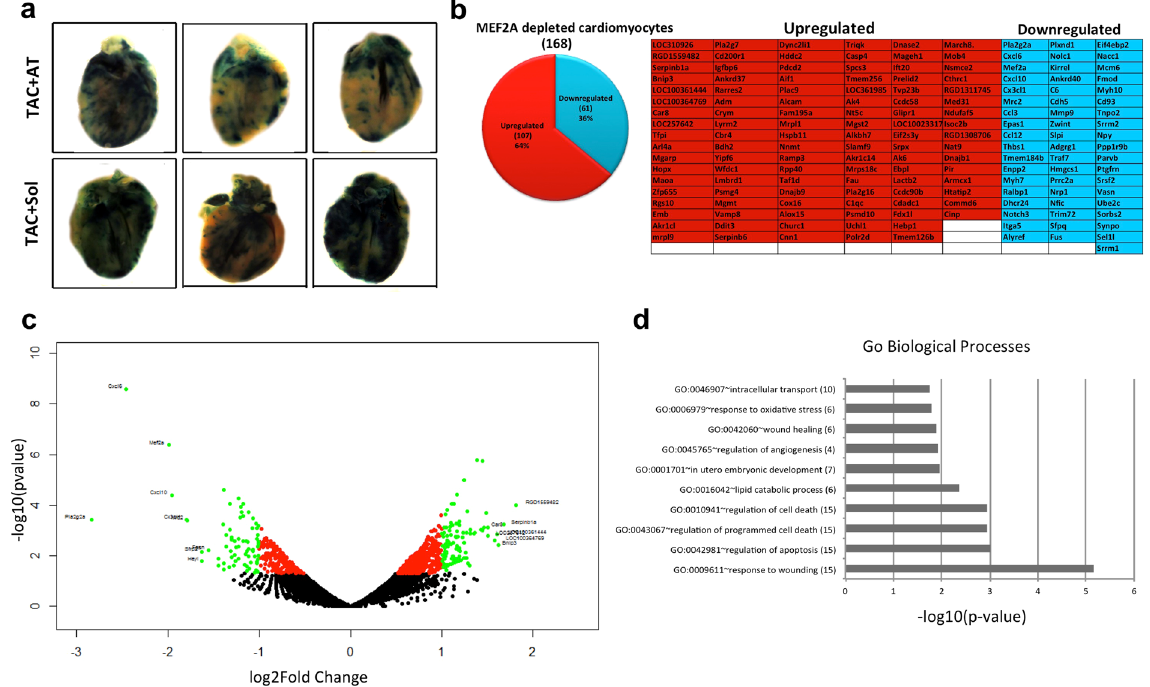
Figure 5. Involvement of MEF2 in cardiac hypertrophy and death. ( a ) Whole heart LacZ staining of MEF2- LacZ mice after TAC + Sol or TAC + AT treatment (n = 3). ( b ) The number of up or downregulated genes in response to MEF2A knockdown in primary cardiomyocytes. A table of genes identified by RNA-seq analysis after MEF2A knockdown (upregulated genes are in red; downregulated genes are in blue). ( c ) A volcano plot depicting up and downregulated genes identified in RNA-seq in response to MEF2A knockdown in primary cardiomyocytes. Black if p-value > 0.05, red if p-value < 0.05, green if log2FoldChange > 1 or <− 1 and p-value < 0.05. Labels are present only on logFC > ± 1.5. ( e ) GO Biological Processes associated with MEF2A knockdown in primary cardiomyocytes. The number of genes is in parentheses beside each